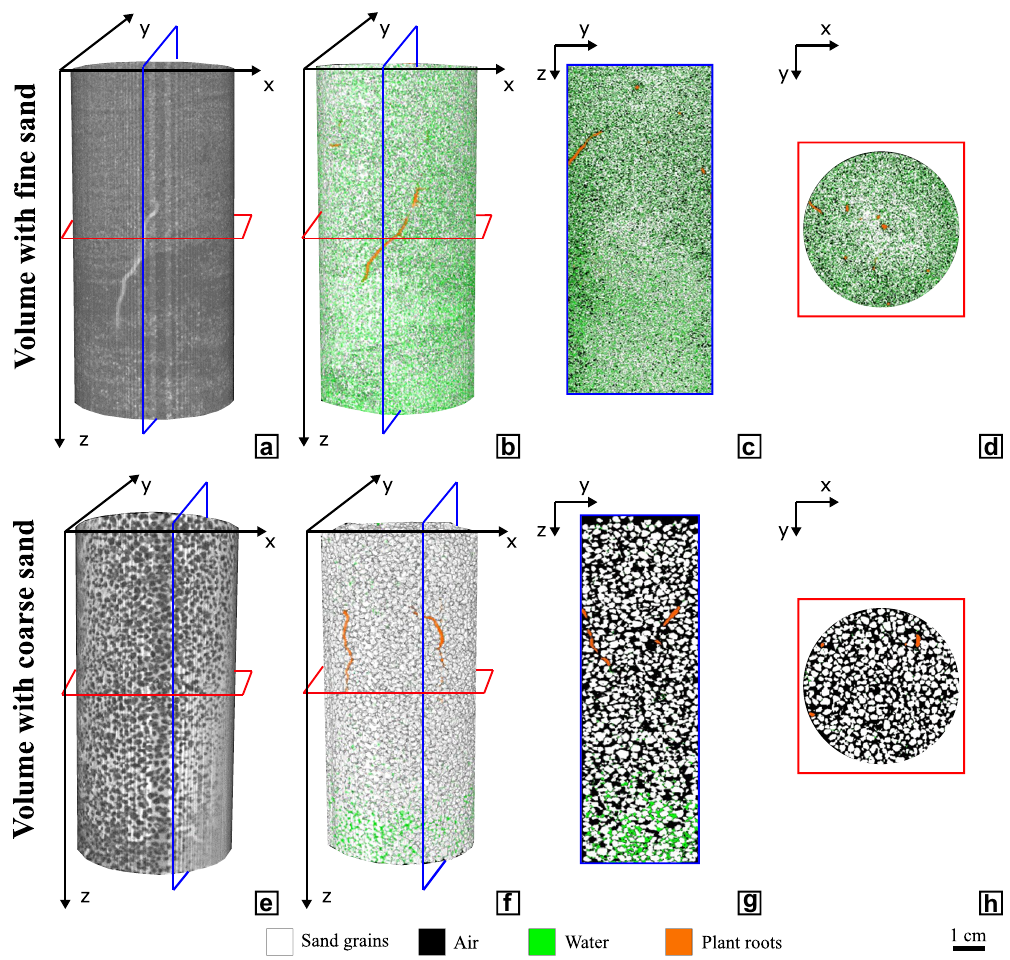
Figure 4. Phase segmentation of two root-soil specimens with the looser sand state – top row: fine Hostun sand (HN31), bottom row: coarse Hostun sand (HN1.5-2). ( a , e ) Greyscale volumes; ( b , f ) four-phased segmented volumes; ( c , g ) vertical section; ( d , h ) horizontal